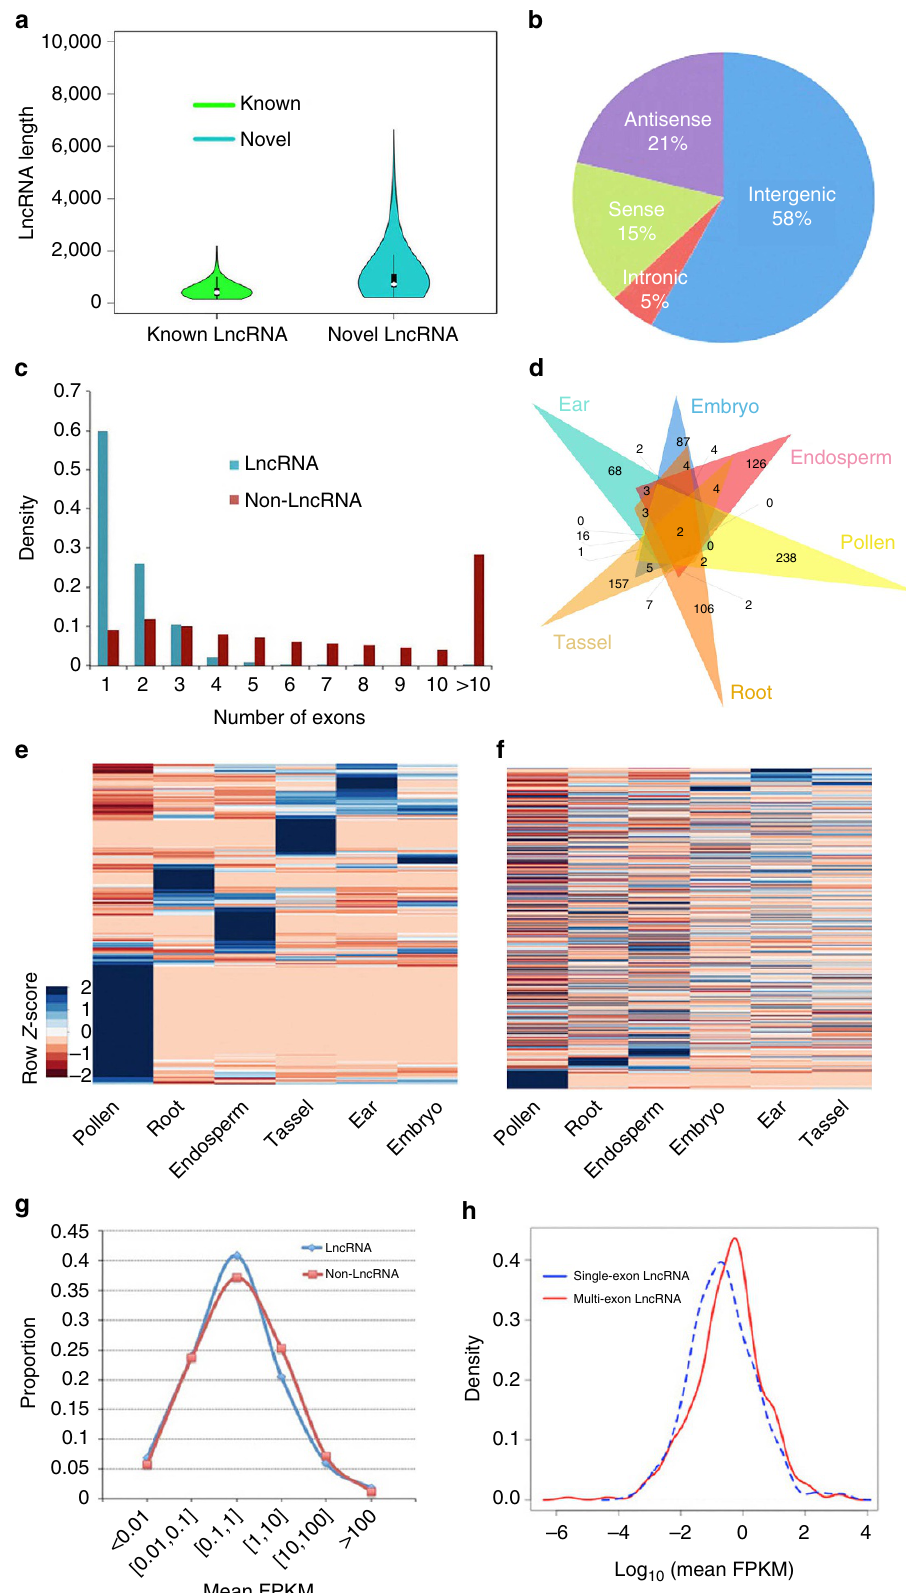
Figure 4 | Characters of identified novel lncRNAs. ( a ) Comparison of lengths of novel lncRNAs identified in this study with previously reported lncRNAs. ( b ) Proportions of four kinds of lncRNA, classified according to biogenesis. ( c ) Number of exons of lncRNAs and non-lncRNAs. ( d ) Overlap of lncRNAs among six tissues. ( e ) Heatmap of lncRNA expression in six tissues. ( f ) Heatmap of non-lncRNA expression in six tissues. ( g ) Comparison of overall expression between lncRNAs and non-lncRNAs. ( h ) Comparison of overall expression between single-exon lncRNAs and multi-exon lncRNAs. NATURE COMMUNICATIONS|7:11708|DOI: